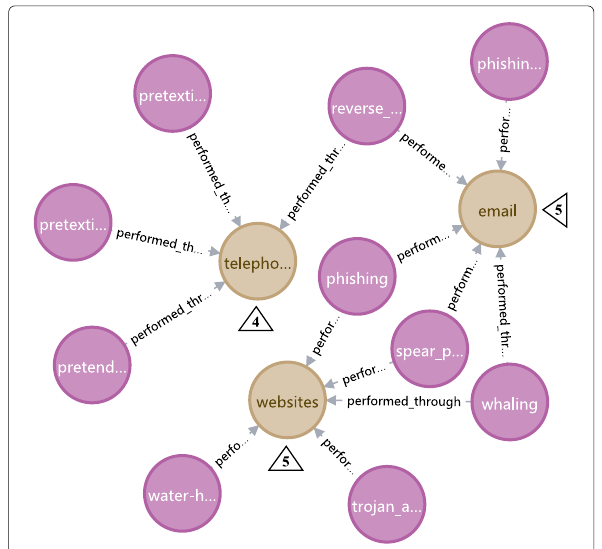
Fig. 22 Find the most used (top 3) attack mediums and social interaction